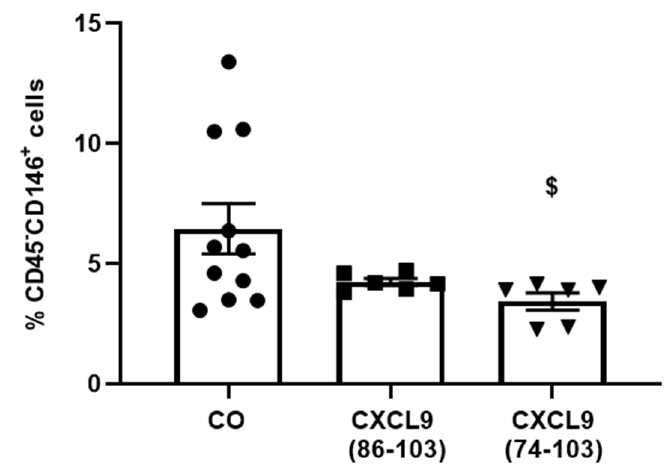
Figure 12. CXCL9(74-103) attenuates tumor angiogenesis in an EGF-dependent MDA-MB-231 breast carcinoma model. Three days after s.c. MDA-MB-231 tumor cell injection, osmotic pumps containing CXCL9(86-103), CXCL9(74-103) [800 µ g in 100 µ L] or PBS were s.c. implanted in tumor-bearing SCID mice. The osmotic pumps allowed the gradual release of treatment for two weeks. Three weeks after tumor cell injection, tumors were removed and digested, and the endothelial cell population within the tumors was analyzed through flow cytometry. [mean ( ± SEM); Mann–Whitney U test; $ p < 0.05 (compared to PBS-treated tumor-bearing mice); (CO group: n = 11, CXCL9(86-103)-treated group: n = 6, CXCL9(74-103)-treated group: n = 6); the experiment was performed